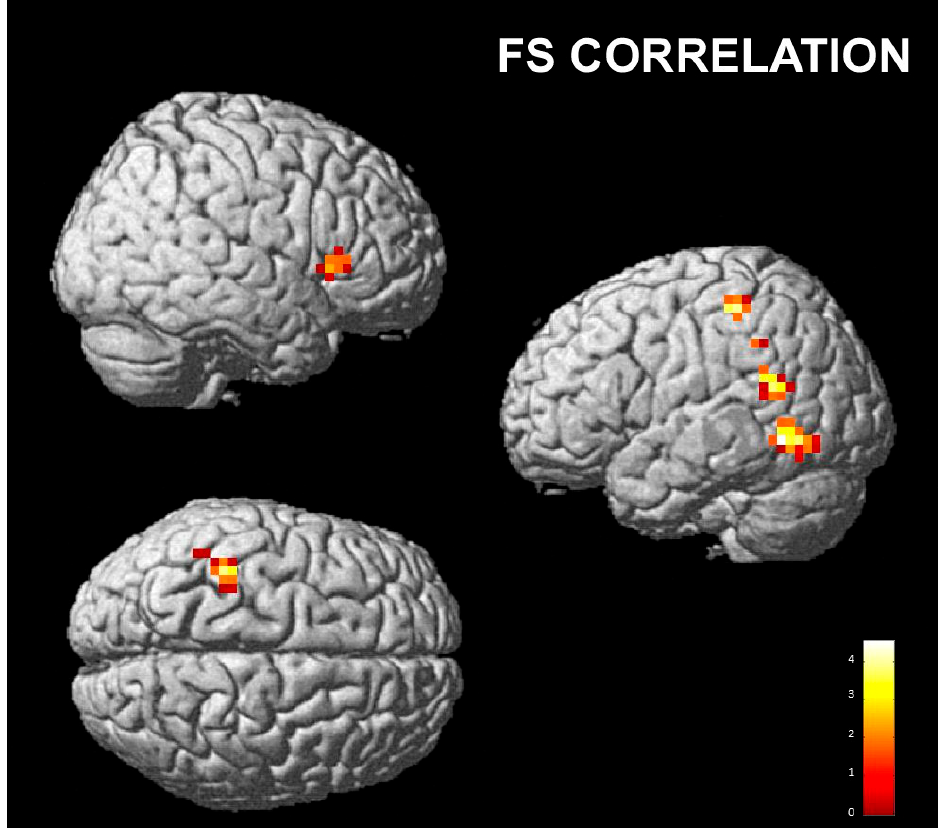
Figure 5. FS correlation with the contrast “posing disgust and perceiving happiness” vs. “posing and perceiving happiness”; cluster size threshold k > 31, corrected at α < 0.05. Same overlay procedure as in Figure 3. Table 4. Peak coordinates of positive correlation with the personal distress